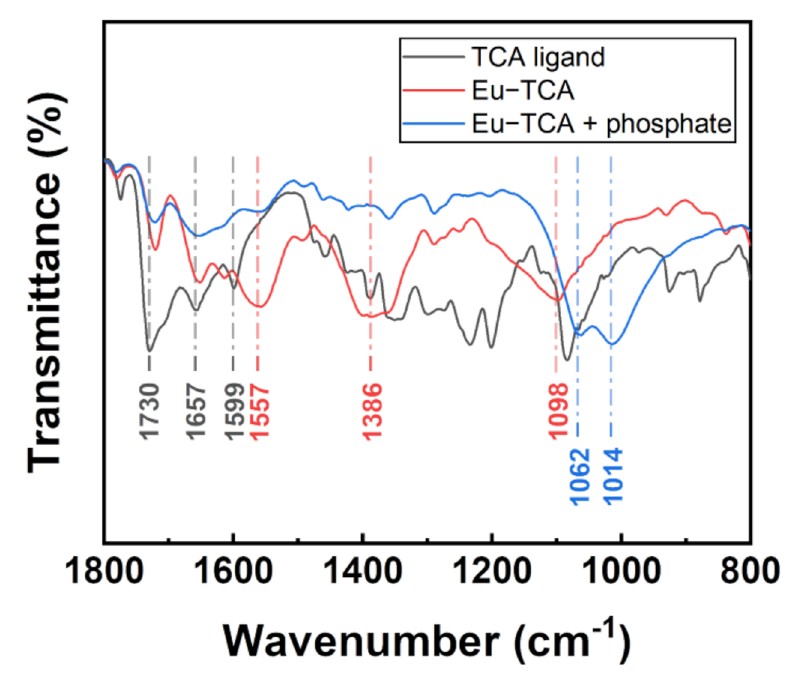
Figure 4. FTIR spectra of the TCA ligand and Eu-TCA before and after incubation with